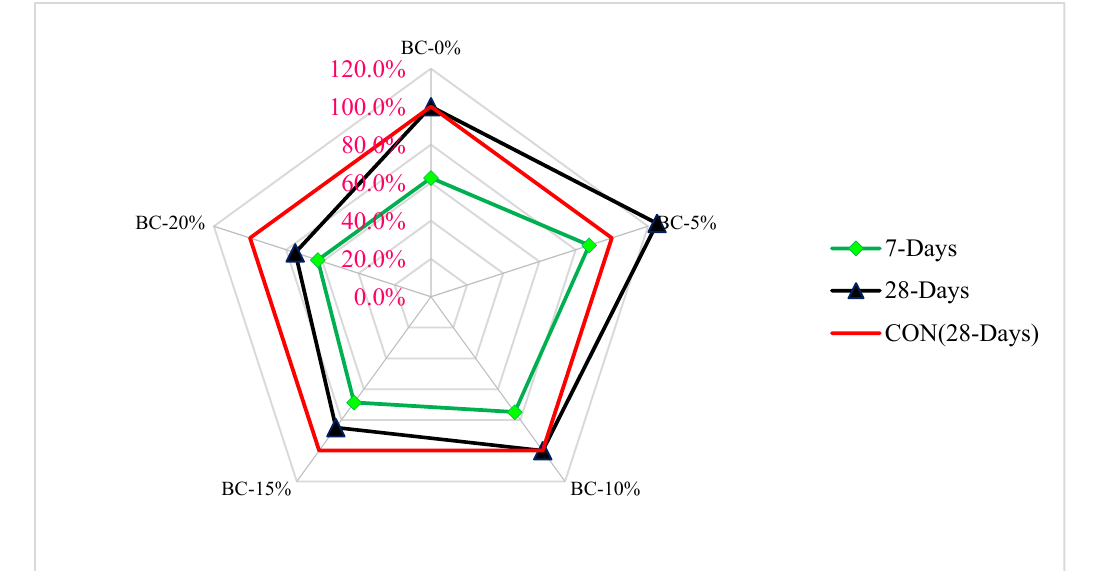
Figure 11. Relative analysis of flexure strength (data source [58]).